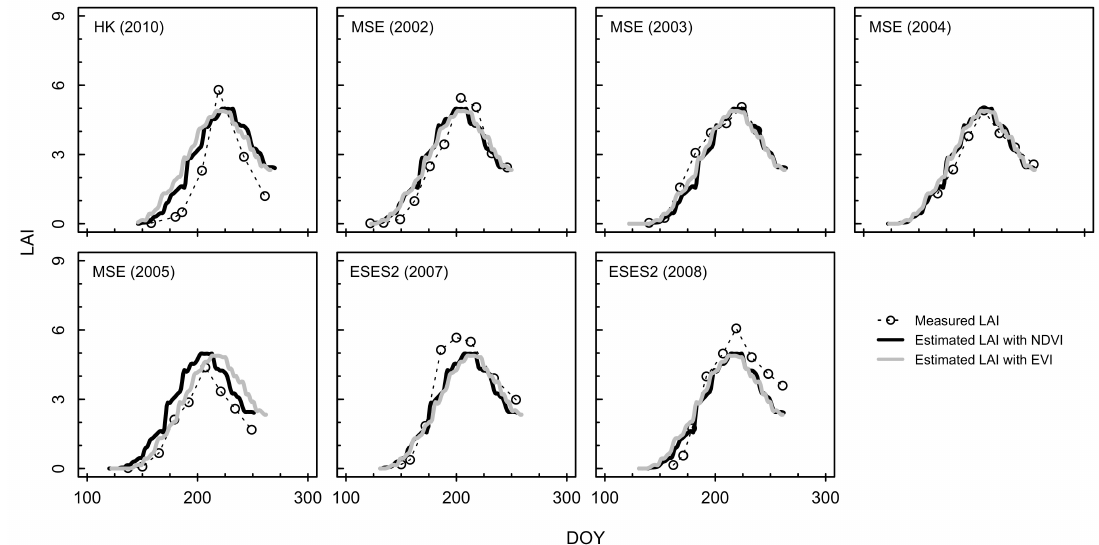
Figure 8. Comparison of the measured and the estimated LAI. Open circle with the dashed line indicating the measured LAI, whereas the solid line indicates the estimated LAI from NDVI (black line) and from EVI (gray line), respectively, using the consistent development curve